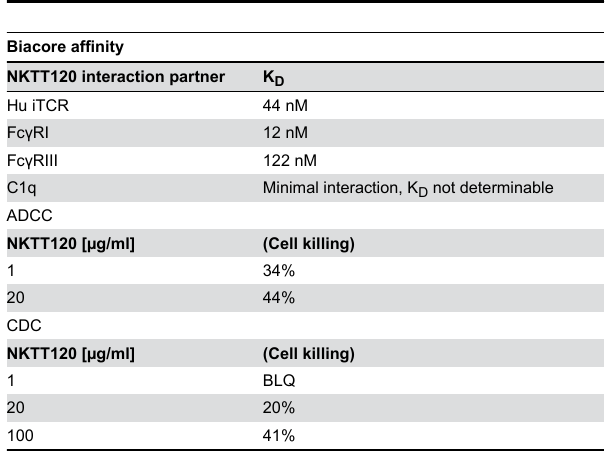
Table 1. Summary of biophysical characteristics of